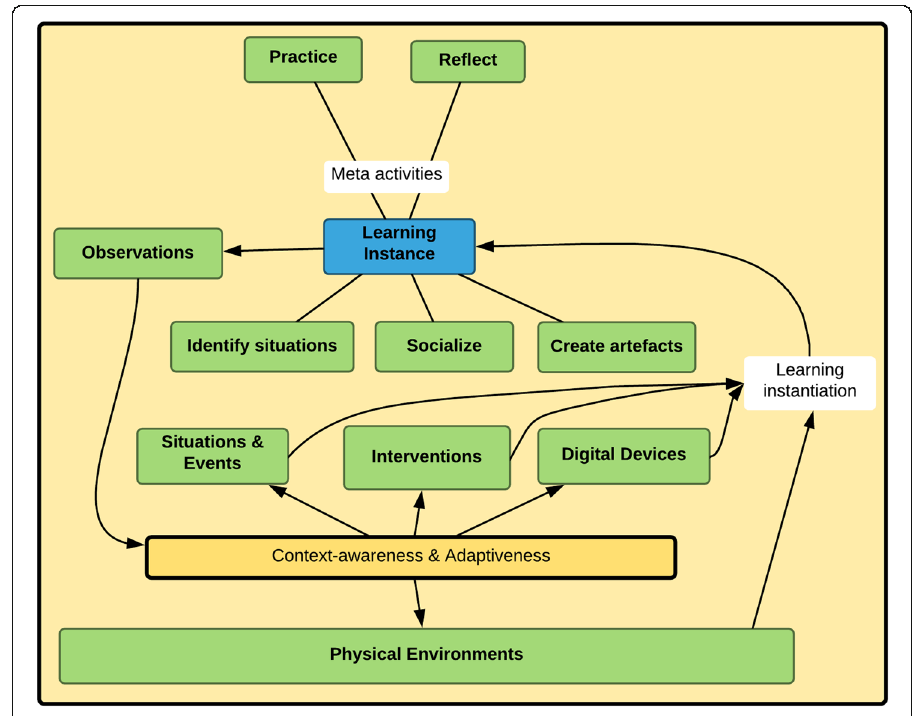
Fig. 6 SLE core reference model (based on Koper,